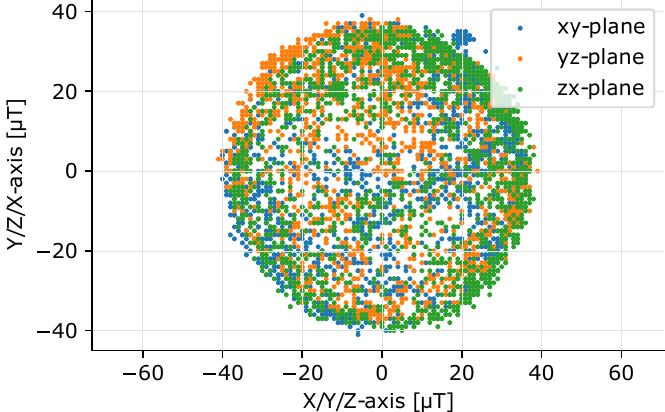
Figure 5. 2D plot of a sphere after rotating the sensor node around each axis after calibration. The circles are perfectly round (near perfect sphere in 3D) and no offsets between the center of the circles and the origin are visible.